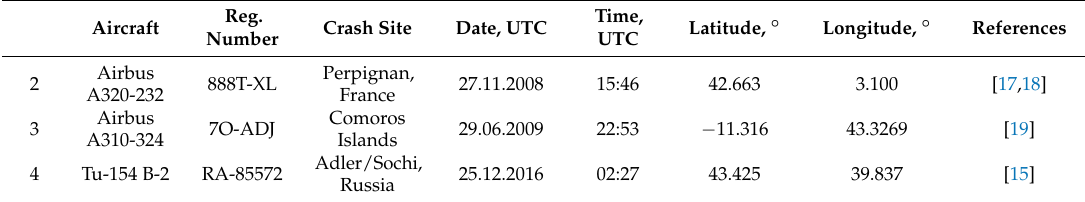
Table 1. The locations of crashed aircraft considered in this study.